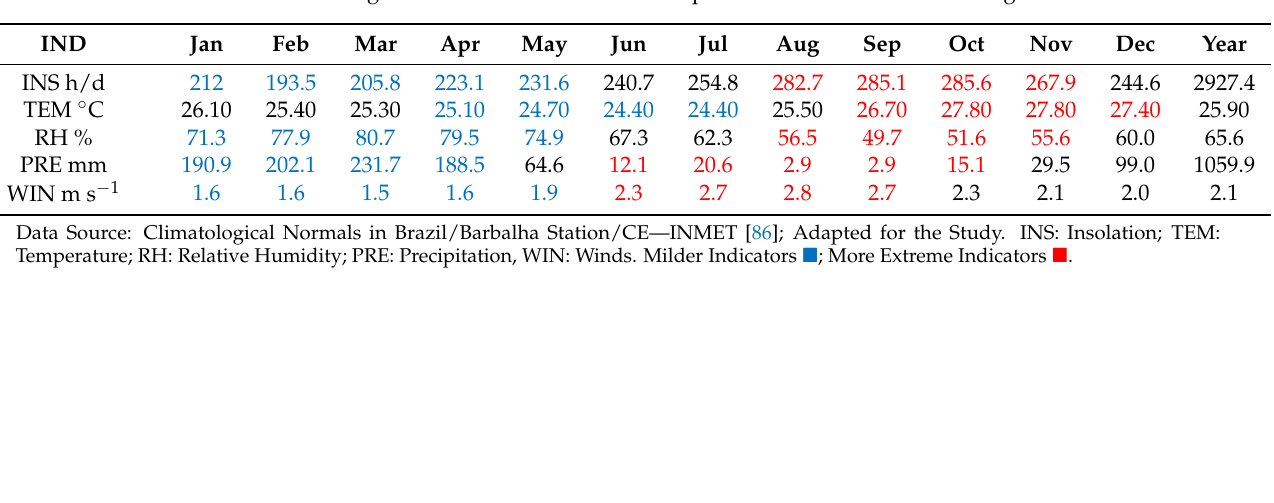
Table 3. Meteorological indicators in the 1981–2010 period in the Cariri Cearense